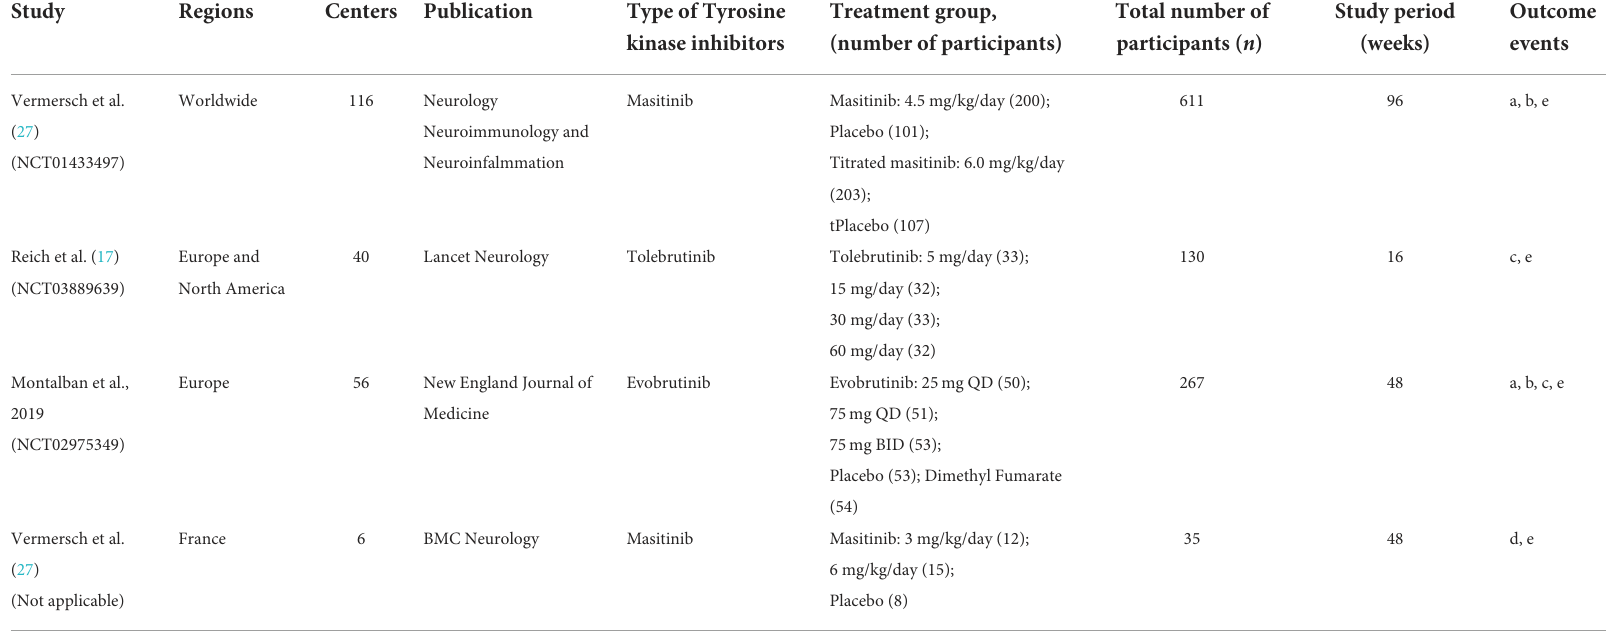
TABLE 1 Characteristics of the included